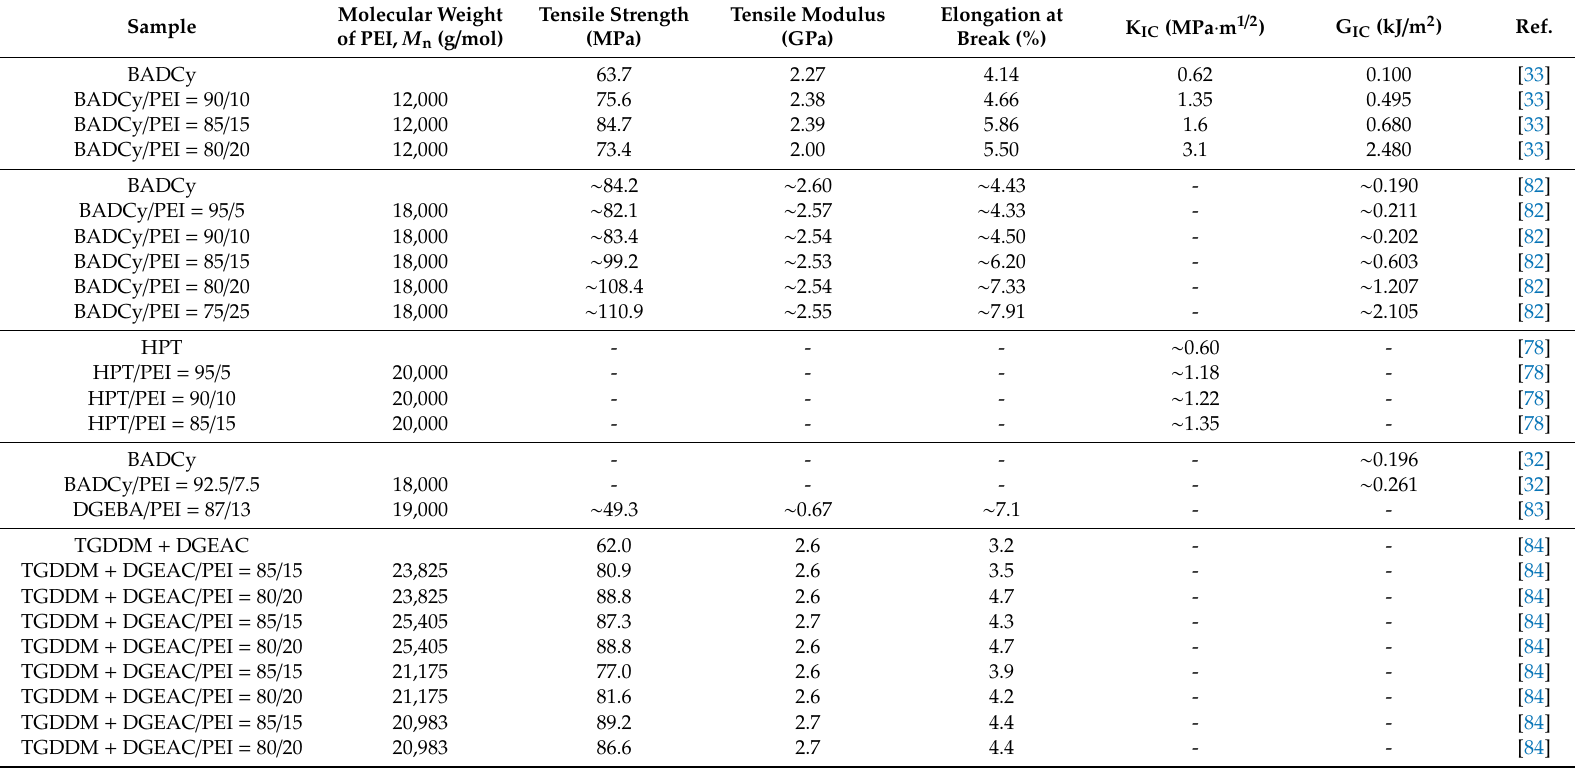
Table 4. Mechanical properties of di ff erent epoxy / poly(ether imide) (PEI) systems investigated in literature at room temperature.